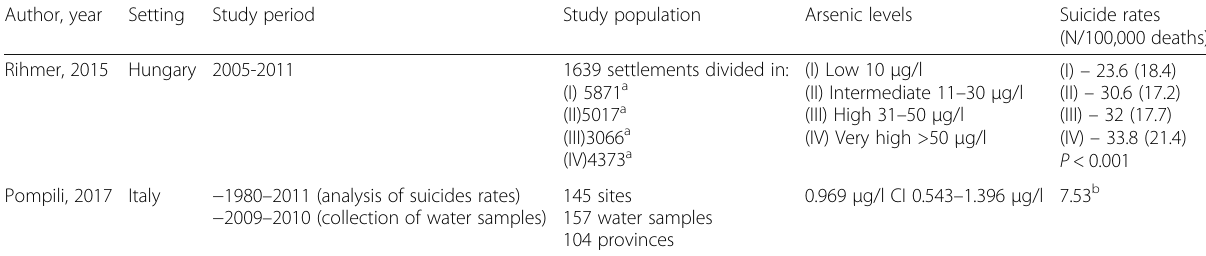
Table 1 Main characteristics of the studies included in the review Author,